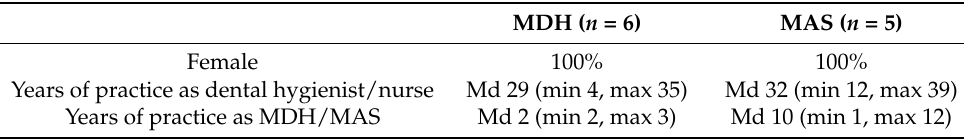
Table 2. The informants, gender, and years of practice. MDH ( n = 6) MAS ( n = 5) Female 100% 100% Years of practice as dental hygienist/nurse Md 29 (min 4, max 35) Md 32 (min 12, max 39) Years of practice as MDH/MAS Md 2 (min 2, max 3) Md 10 (min 1, max 12) MDH = Municipal dental hygienists, MAS = Local head nurses, Md =